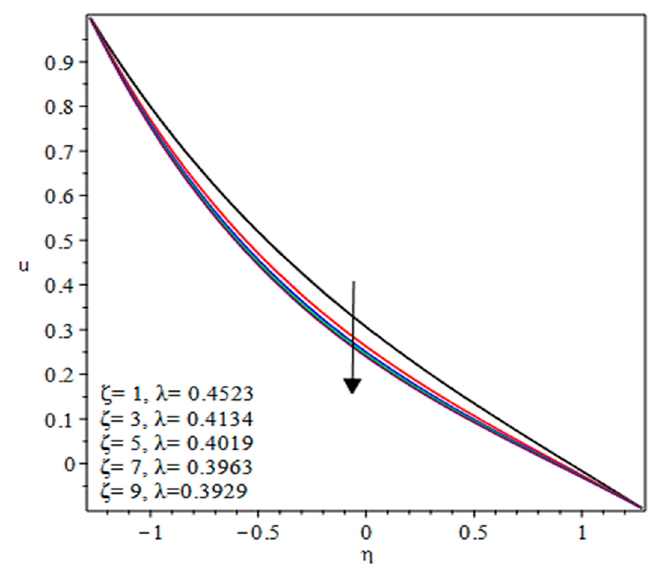
ζ influence on the velocity profile at